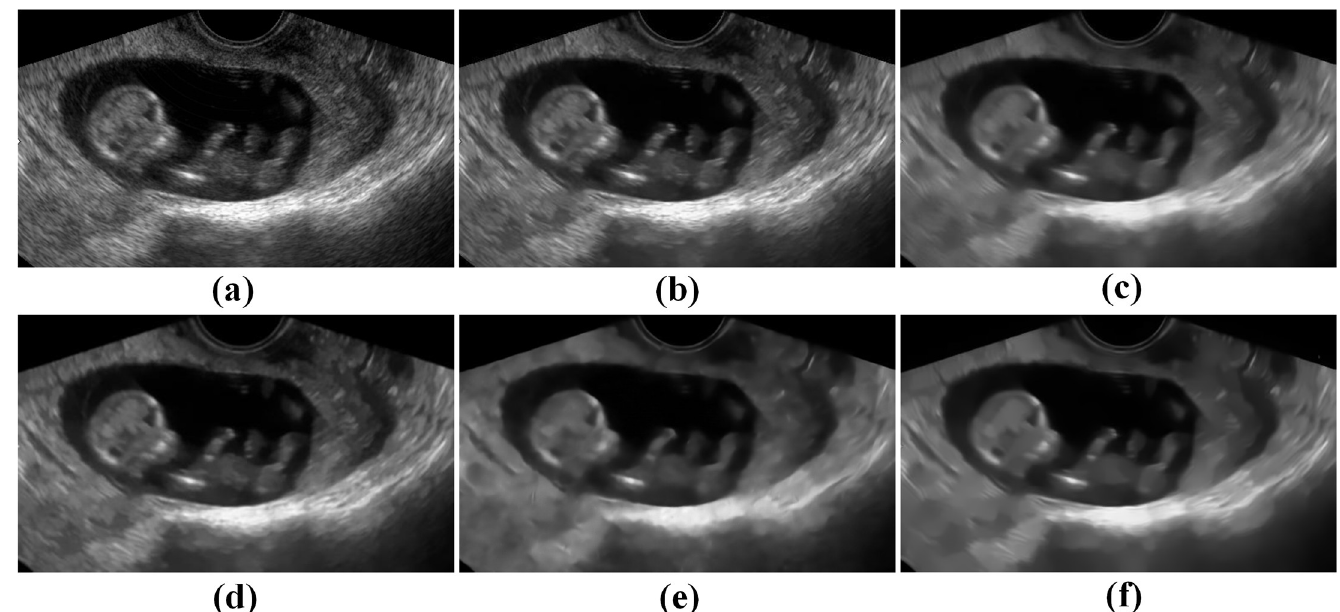
Fig 9. Comparison of restoration performance on a real fetal ultrasound image for the NLM-based and DnCNN methods. (a) original image, (b) TNLM filter, (c) OBNLM filter, (d) NLMLS filter, (e) DnCNN filter, and (f) PPCA-NLM filter.